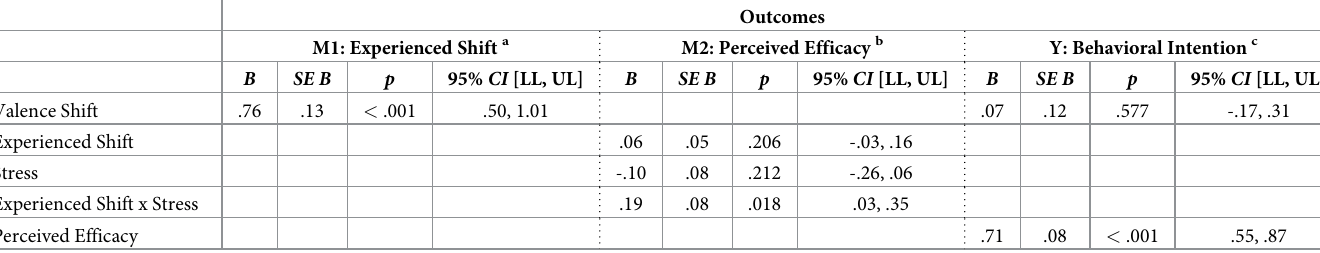
Table 2. Results of moderated mediation.